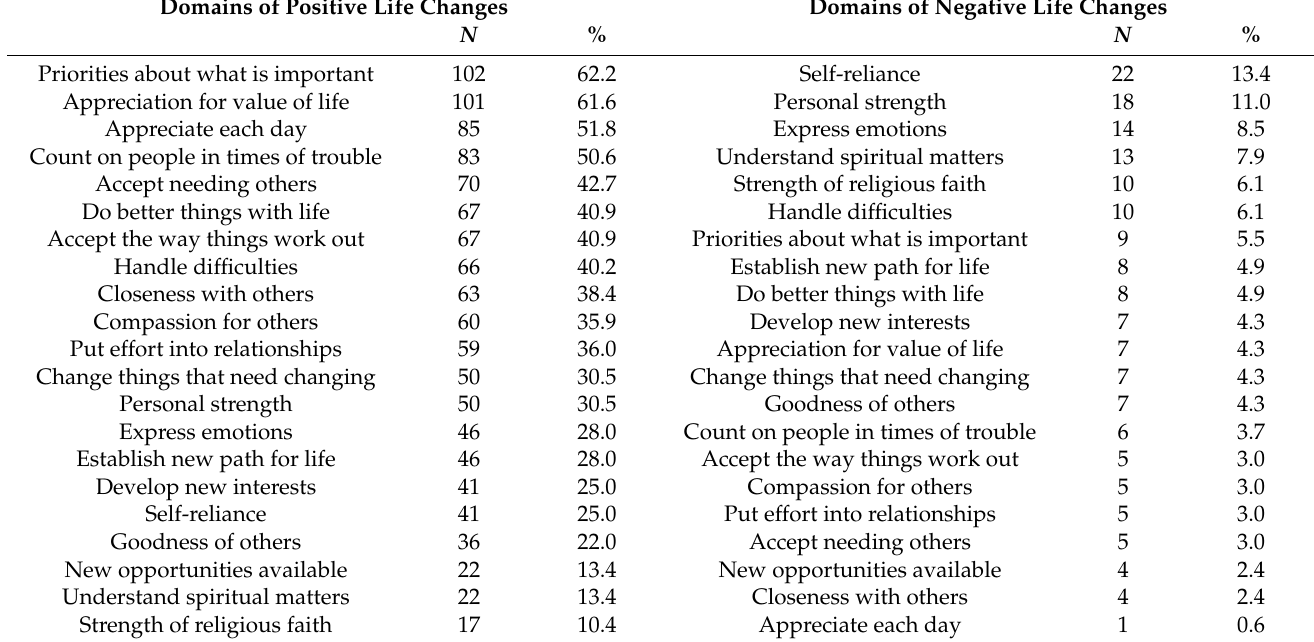
Table 3. Frequency of patients reporting positive and negative change for each life domain ( N = 164).